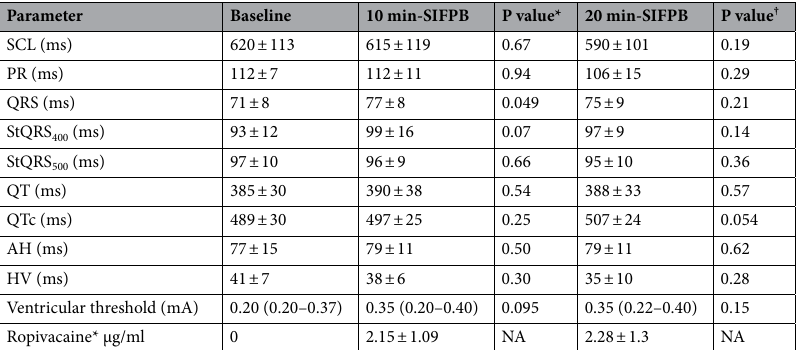
Table 3. Electrocardiographic and electrophysiological parameters. Comparison between baseline parameters and those obtained 10 and 20 min after serratus intercostal fascial plane block coinciding with maximum arterial ropivacaine levels. N = 8. Data are shown as medians and interquartile range (IQR) for non-normally distributed data using the Shapiro–Wilk test, and as means ± standard deviation for normally distributed variables. SIFPB serratus intercostal fascial plane block, SCL sinus cycle length, PR PR interval, QRS QRS duration, St QRS 400 duration of stimulated QRS at a paced cycle length of 400 ms, St QRS 500 duration of stimulated QRS at a paced cycle length of 500 ms, QTc corrected QT interval, AH atrial His interval, HV His- ventricular interval. *Arterial ropivacaine